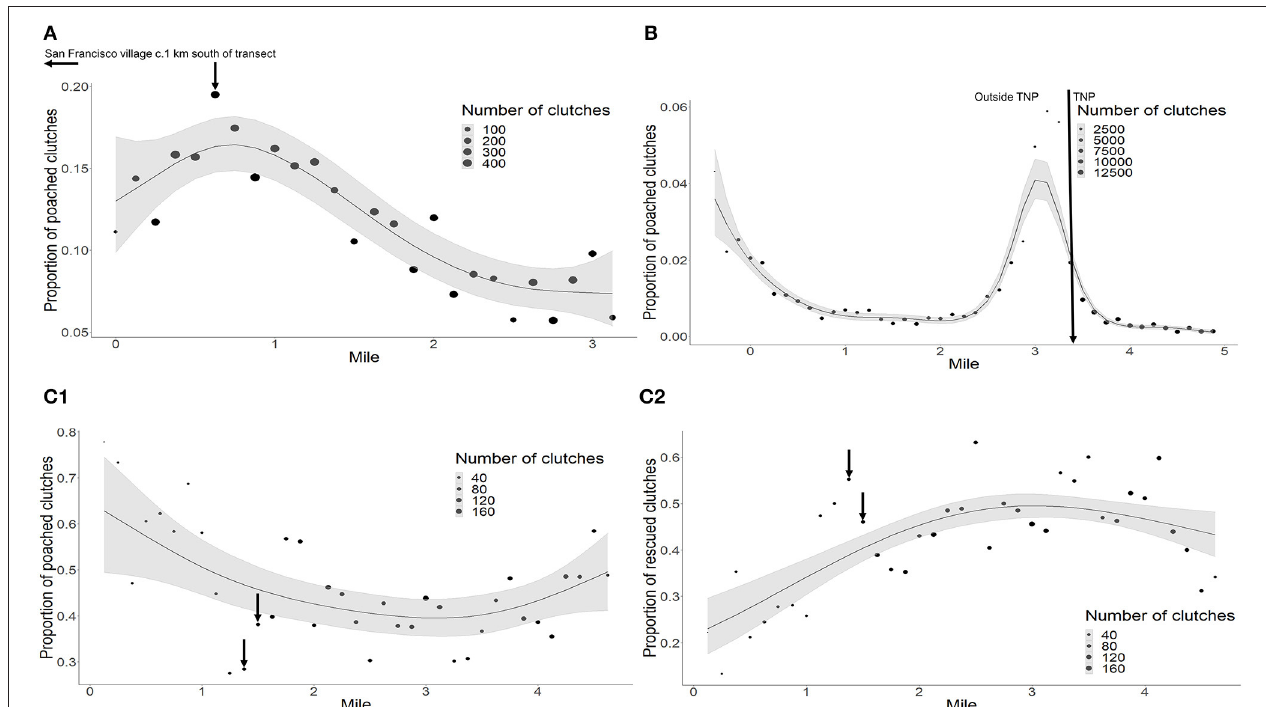
FIGURE 3 | Spatial poaching trends across the beach transects. (A) Playa Norte, arrow depicts location with highest poaching frequency and a property with easy access to the beach. Data are recorded in miles (transect), geographical locations outside transects are in km. (B) Tortuguero, arrow depicts National Park border, (C1,C2) . Pacuare, arrows depict LAST hatchery and volunteer accommodations. Point size indicates the number of clutches laid on that mile of beach. Solid line indicates the model fit, grey shaded areas are 95%